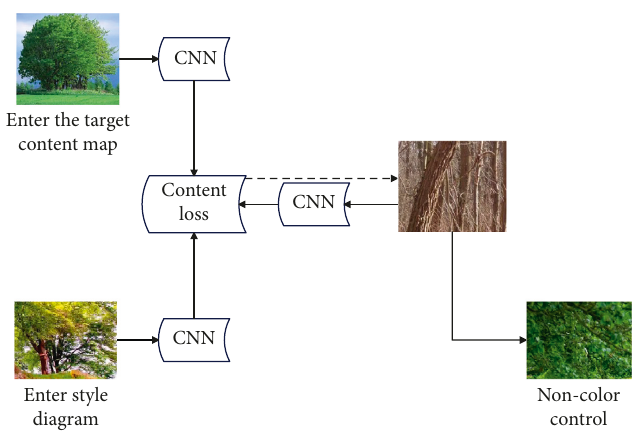
Figure 8: CAD fractal art pattern design system fused with RBF neural network algorithm. Table 1: Experimental results of nonequal scaling.